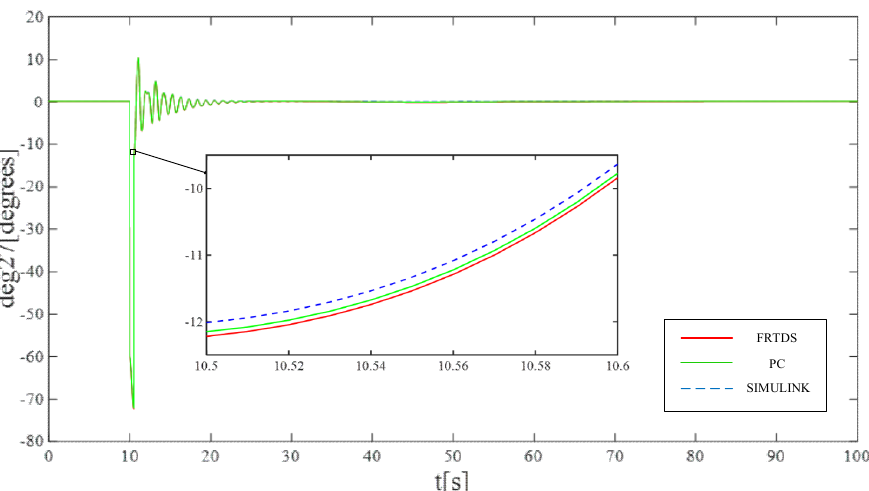
Figure 12. The voltage phase angle of bus 27.